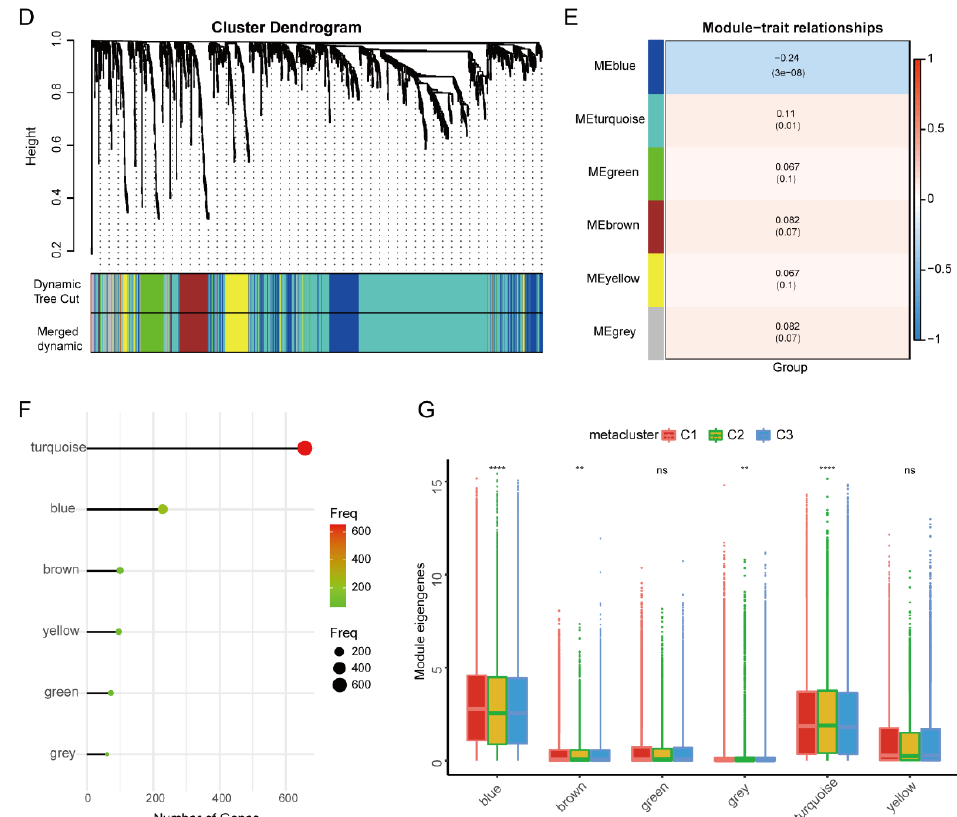
Figure 8. Identification of immune gene co-expression modules of HNSC. ( A ) Scale-free fit index for various soft-thresholding powers ( β ), and mean connectivity for various soft-thresholding powers. ( B ) Dynamic tree of feature modules. ( C ) Clustering tree of feature modules. ( D ) Dendrogram of all differentially expressed genes clustered based on a dissimilarity measure (1-TOM). ( E ) Relationship between modules and immune subtypes. ( F ) Gene numbers in each module. ( G ) Differential distribution of feature vectors of each module in HNSC subtypes. Expression of the identified gene modules in the immune subtypes. ** p < 0.01 and **** p < 0.0001. It was found that the genes of the MEblue module were significantly enriched